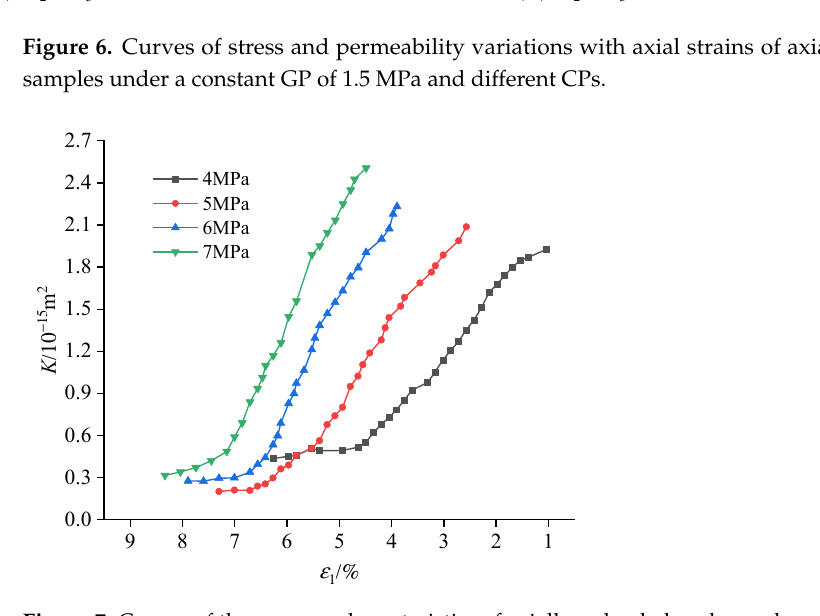
Figure 7. Curves of the seepage characteristics of axially unloaded coal samples under a constant GP of 1.5 MPa and different CPs.